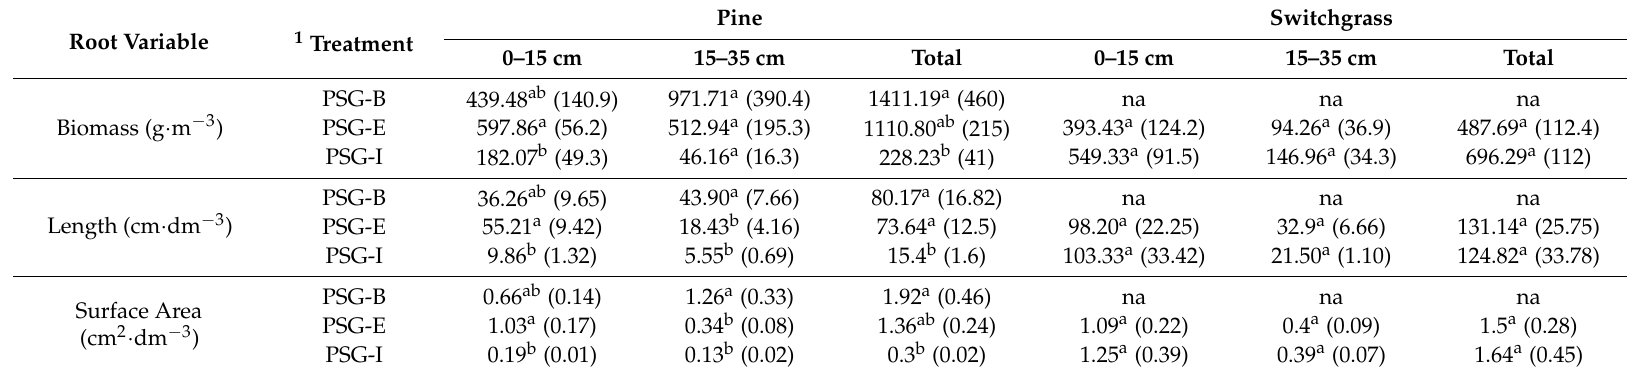
Table 4. July switchgrass and loblolly pine root biomass (g · m − 3 ), average root length (cm · dm − 3 ), and average root surface area (cm 2 · dm − 3 ) in the exclusion cores Means are followed by ± 1 standard errors in parentheses. Different letters following the means indicate significant differences between treatments for a particular depth at p <